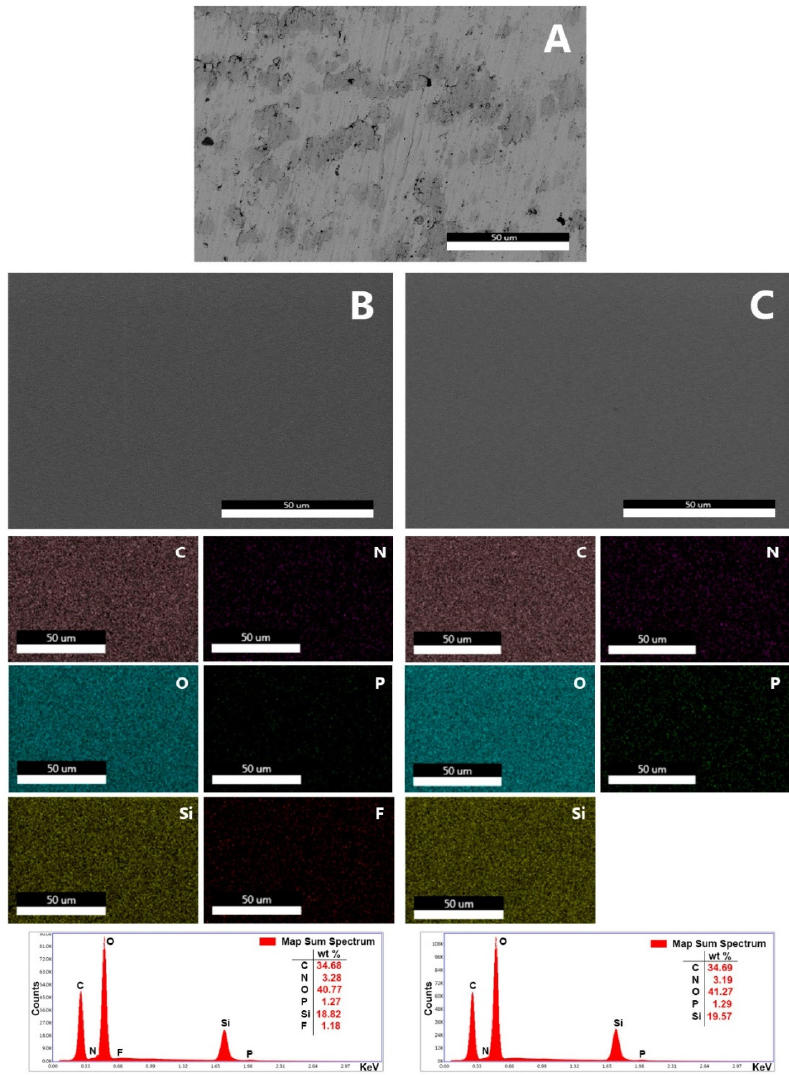
Figure 1. CBS-SEM micrographs of the Ti-powder metallurgy substrate ( A ), F100 ( B ) and A100 ( C ) surfaces. Energy dispersive spectroscopy (EDS) elemental mapping images and EDS spectrum of F100 ( B ) and A100 ( C ) coatings showing the distribution of chemical elements. C: Carbon; N: Nitrogen, O: Oxygen; P: Phosphorus; Si: Silicon; F: Fluor.